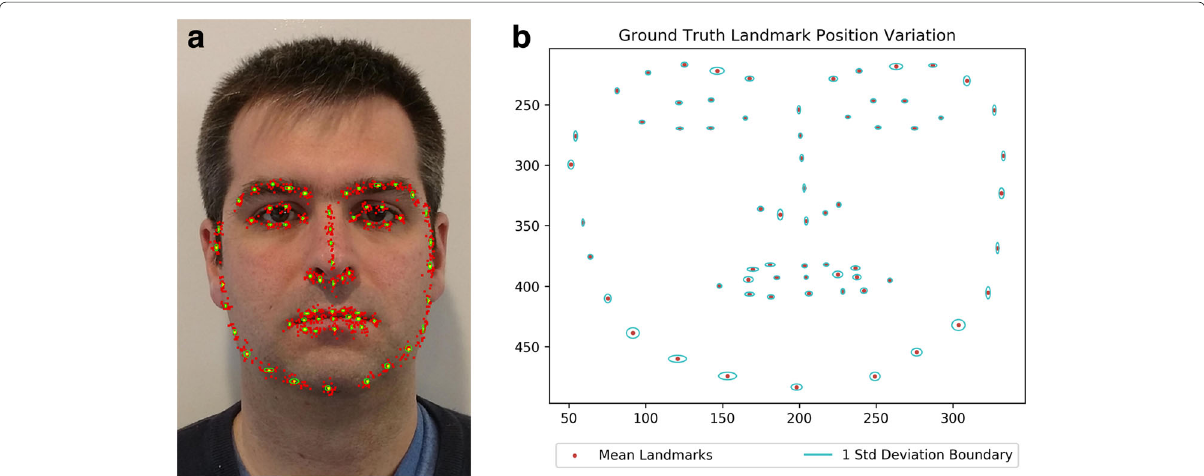
Fig.4 Ground truth variation. a Ground truth landmarks provided by individual annotators. Landmarks in red are the individual positions provided by the annotators, while the yellow points indicate the mean position for each of the landmarks. b Ground truth landmarks variation. Points in red are the mean positions for each landmark, while the major and minor axes of the blue ellipses indicate the x and y variance of the ground truth